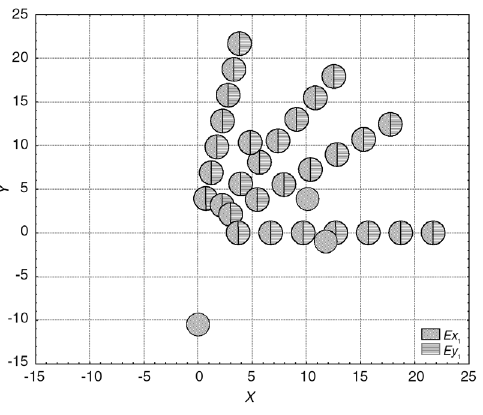
Fig. 8. Calibration of the standard measuring array (two-component orthogonal dipoles centered at the point (0 , 0) by using point source placed at the point ( x, y )). The circular diagram at each given point of the tablet shows the relation between the signal com- ponents of measuring array produced by a point source located at this point.